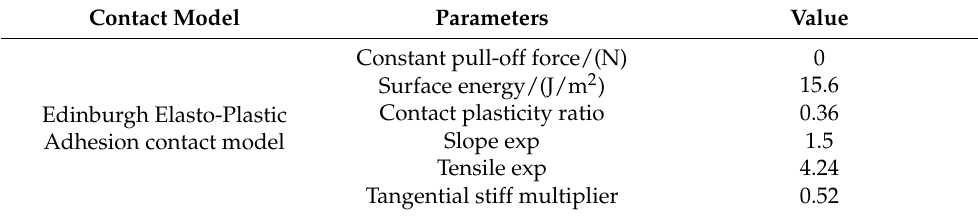
Table 4. Contact model parameters of